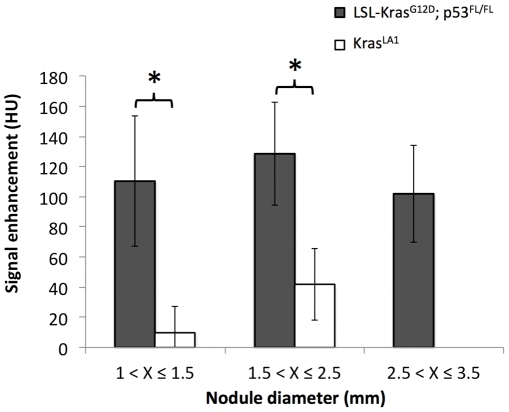
Differential signal enhancement on day 7 in the two primary lung cancer nodules.(* indicates p<0.05).